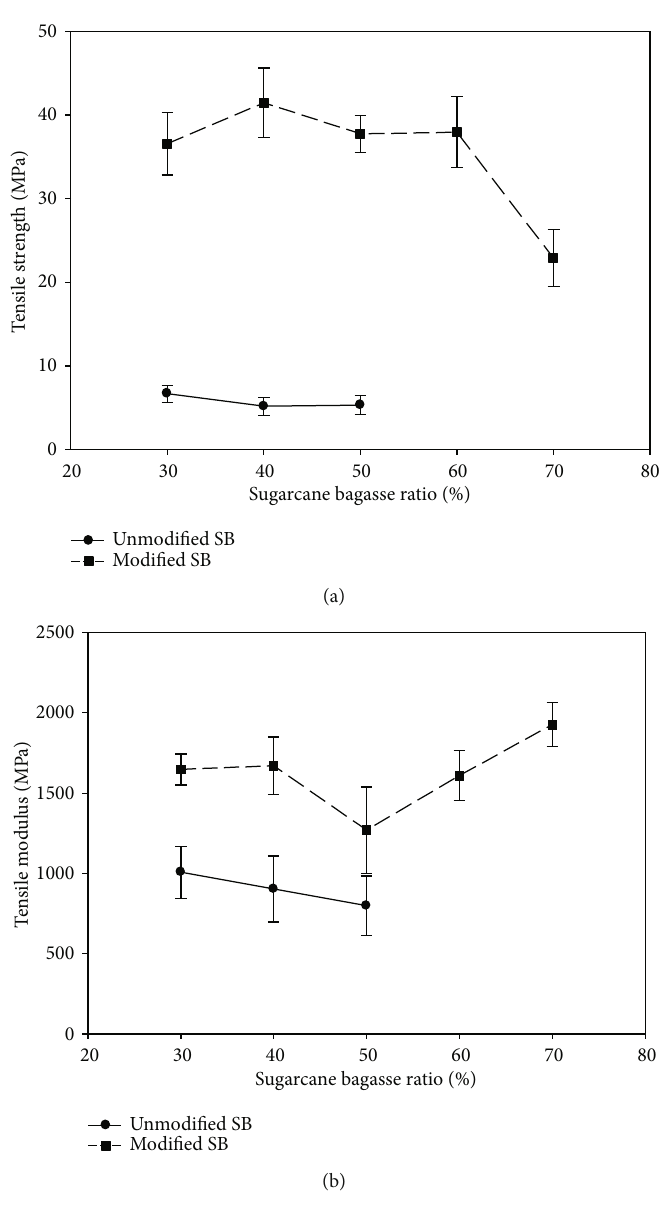
Figure 12: Tensile properties of PPG 1000 elastomers: (a) tensile strength and (b) tensile modulus.